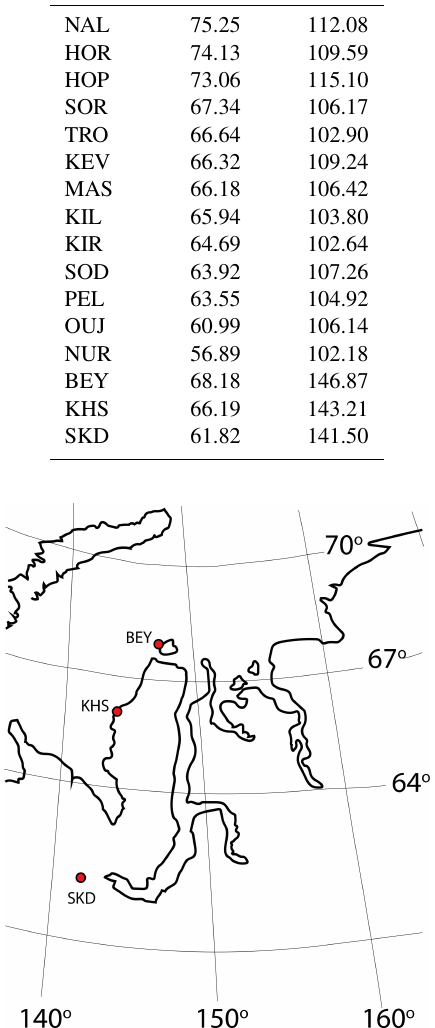
Figure 1. Map of stations on the Yamal Peninsula.